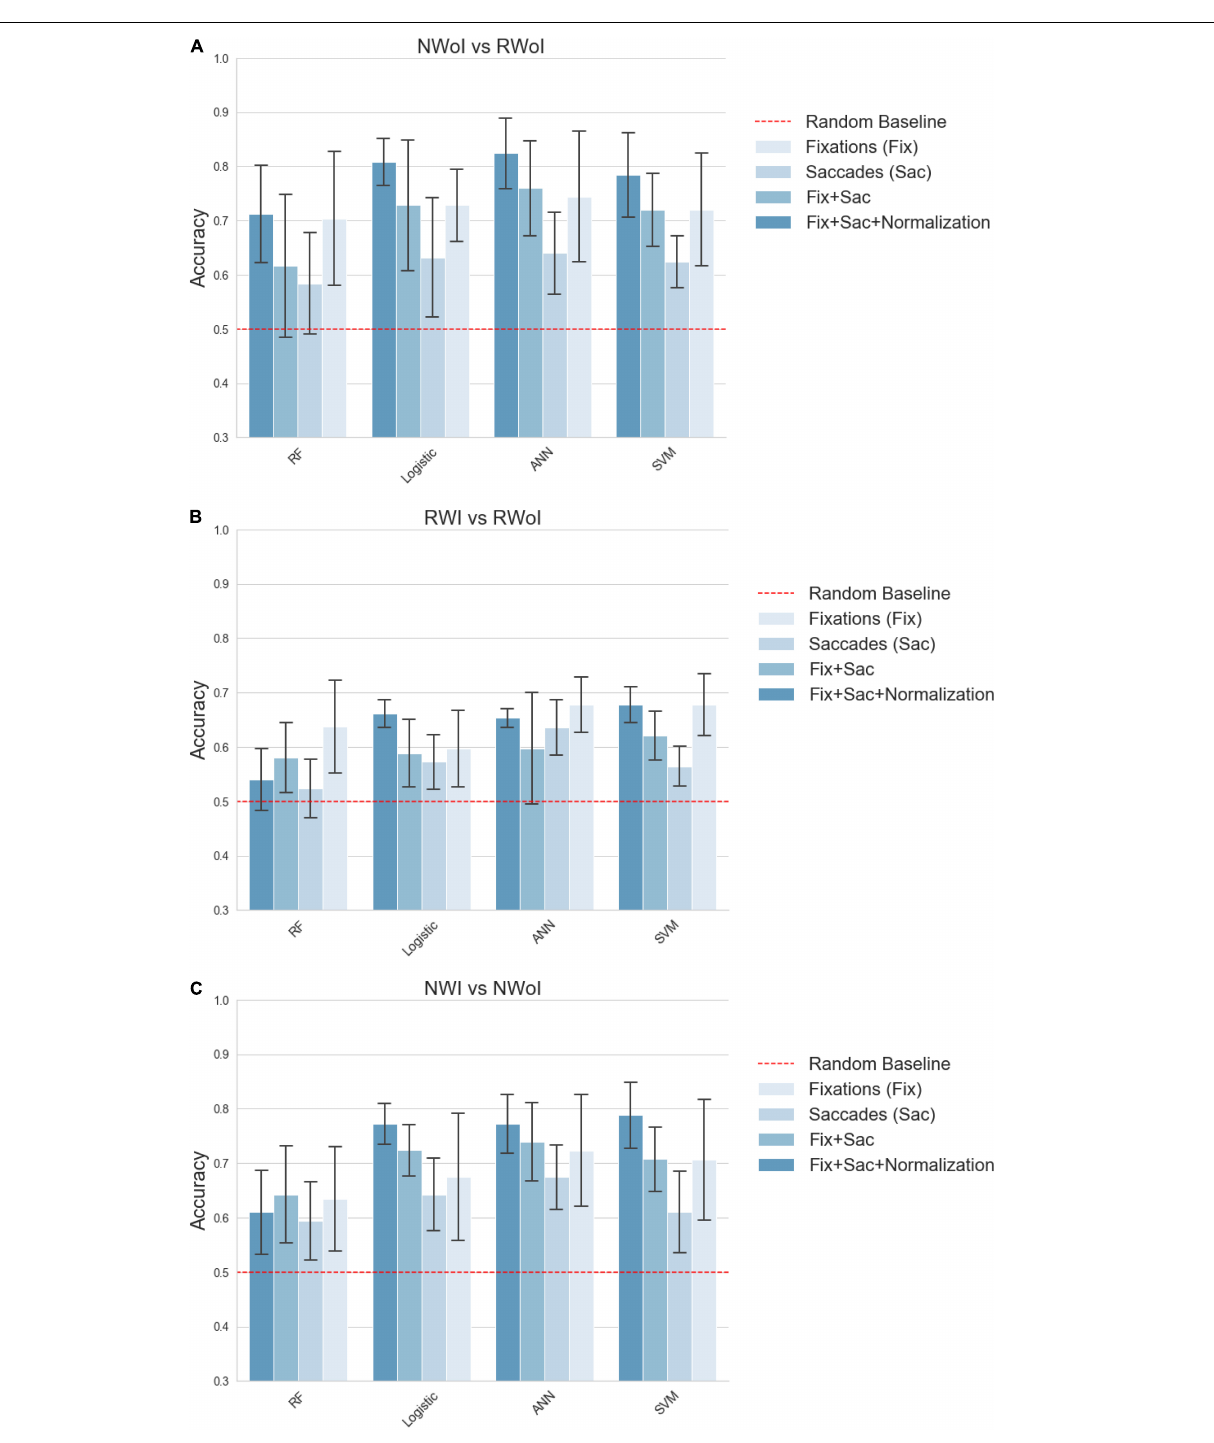
FIGURE 5 | Classification performances in terms of Accuracy . (A) Naming without Interference vs Reading with Interference. (B) Reading with Interference vs Reading without Interference. (C) Naming with Interference vs Naming without Interference. Each plot represents a different binary classification task, indicated in the title. Bars indicate the average Accuracy on a 5-fold cross validation setting, while the confidence interval represented by black lines on the top of each bar indicates the standard deviation. Each group of contiguous bars refers to the performance achieved by the same classifier: RF, Logistic, ANN and SVM. Bar’s color indicates the set of features fed as input to the classifier: Fix (features related to fixations), Saccades (features related to saccades), Fix + Saccades (features related to fixations and saccades), Fix + Saccades-norm (features related to fixations and saccades with subject-wise normalization). The dashed red line sets the reference of the random baseline